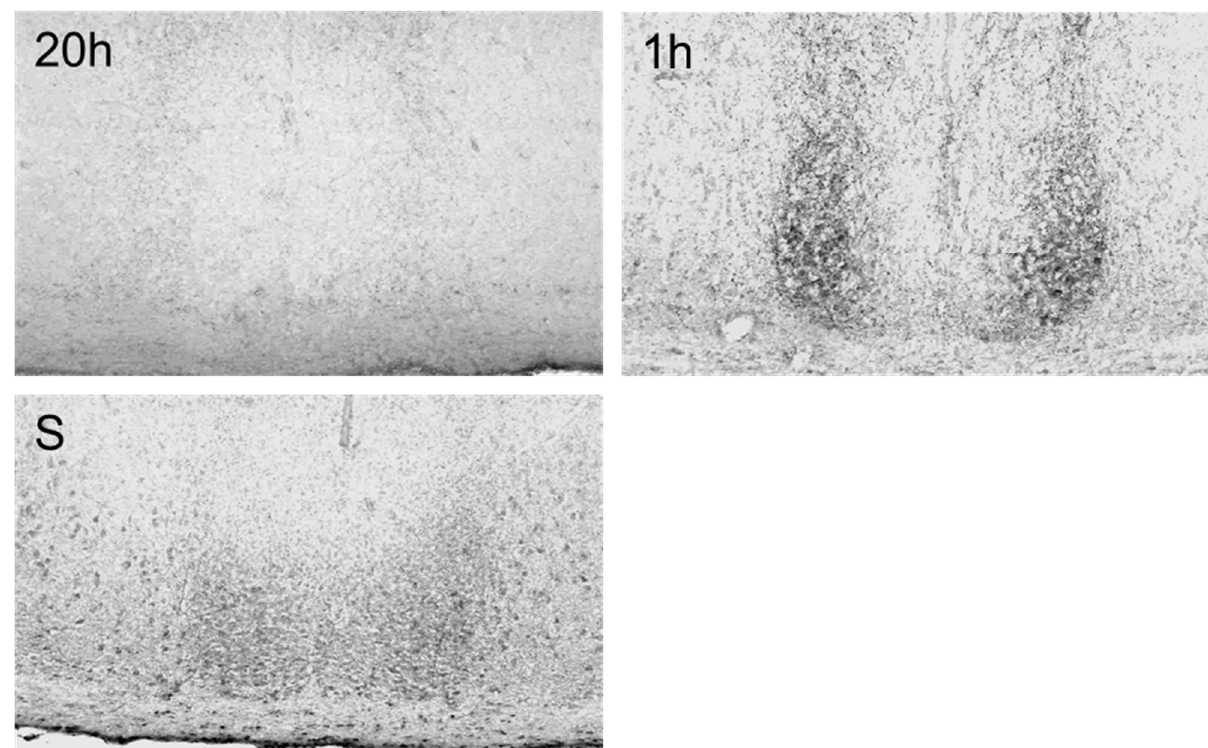
Figure A5. Gastrin releasing peptide immunoreactivity in the suprachiasmatic nuclei of Syrian hamsters. Comparison between 20 h manual sleep deprivation (20 h, group 3c), 1 h manual sleep deprivation (1 h, group 3a) and sleep (S, group 5). Magnification: 50×.